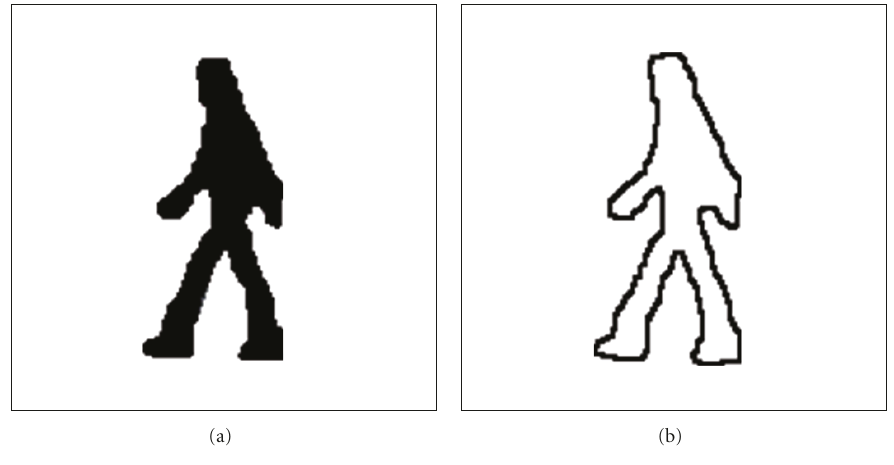
Figure 2: Human binary silhouette and its contour.